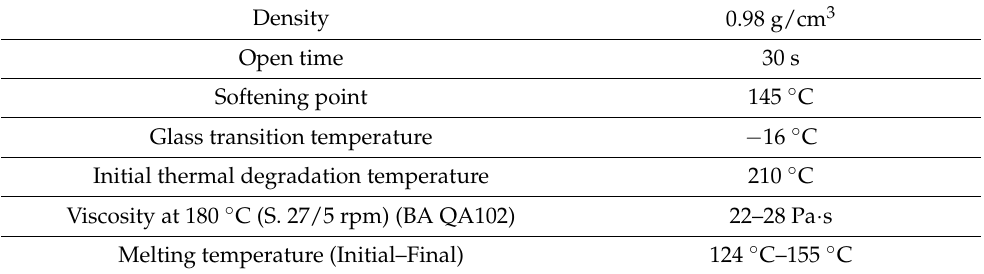
Table 1. Properties of the polyolefin adhesive [9,10,12].